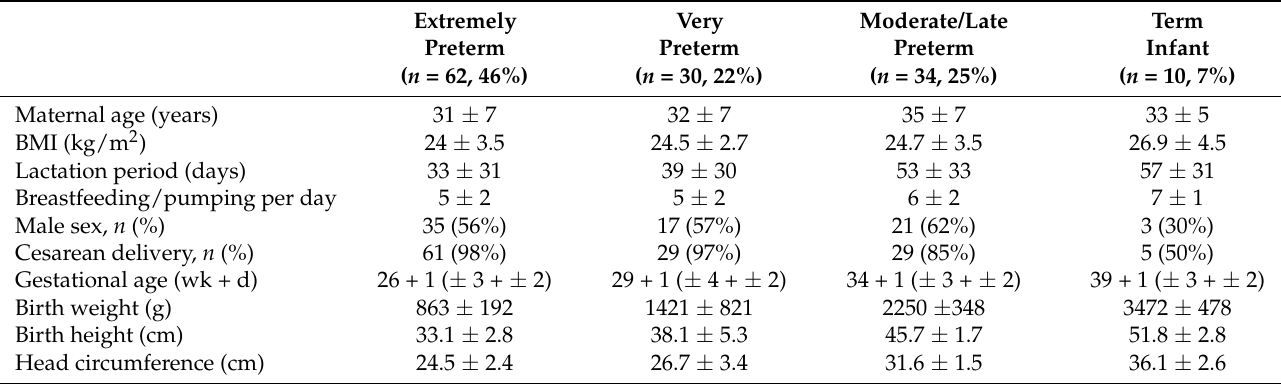
Table 3. Maternal and infant characteristics divided into different GAs.